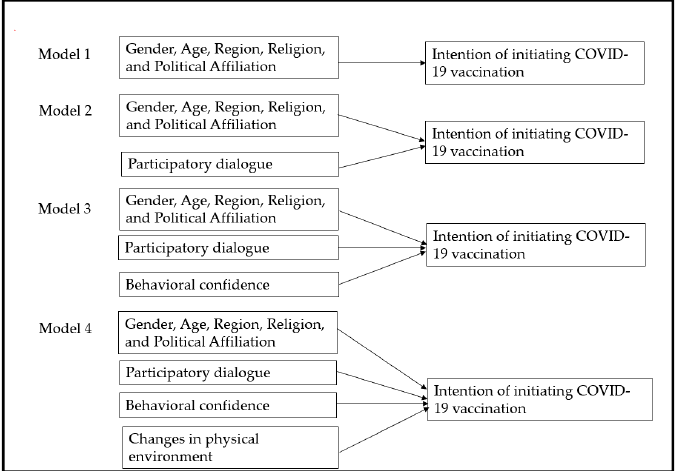
Figure 1. Regression model building process indicating hierarchical entry of predictors to explain variance in the dependent variable (intention of initiating COVID-19 vaccination ).